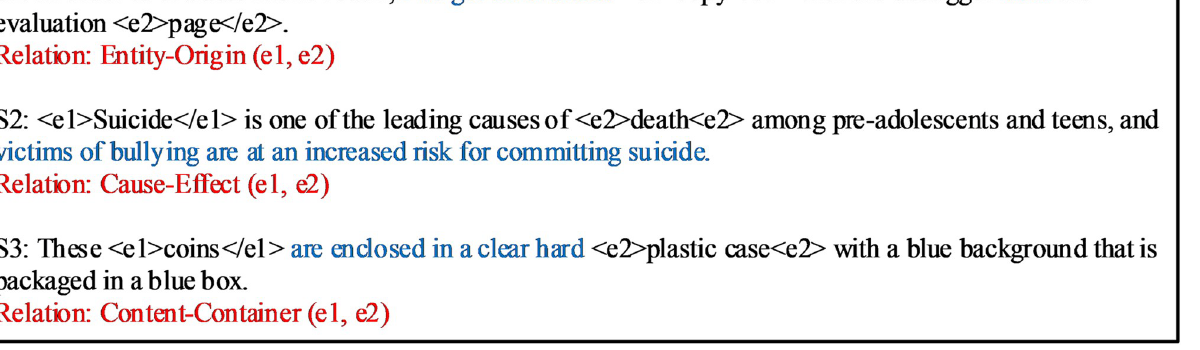
Fig 2. The semantic information in the sequence. This example come from SemEval2010 Task8.